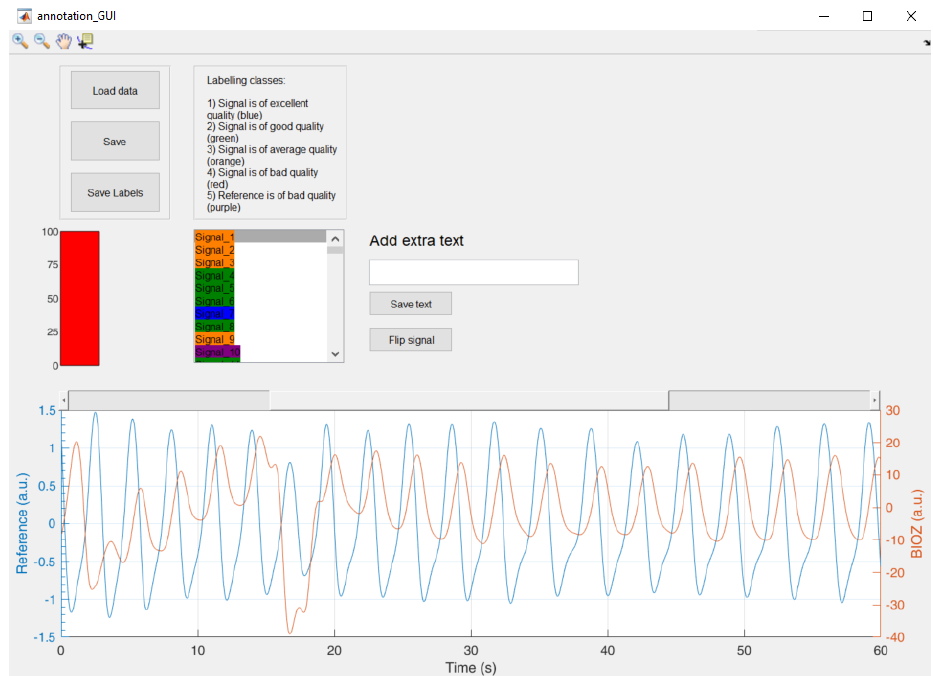
Figure A1. Graphical user interface for visualizing, commenting and labeling each